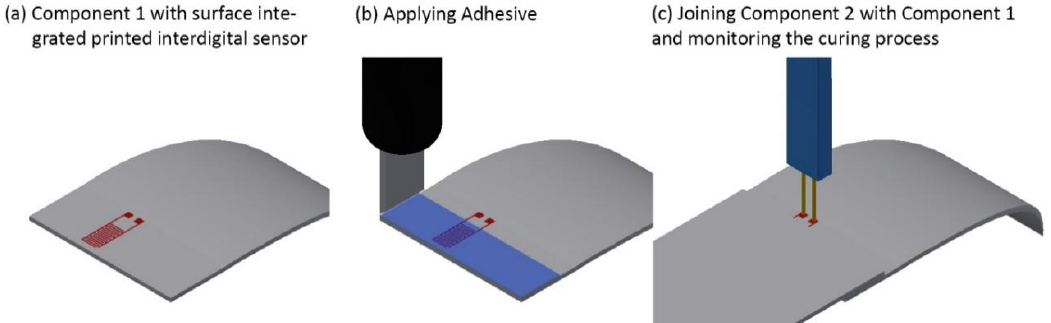
Figure 1. Schematic automated fabrication process with integrated interdigital structure for cure monitoring.